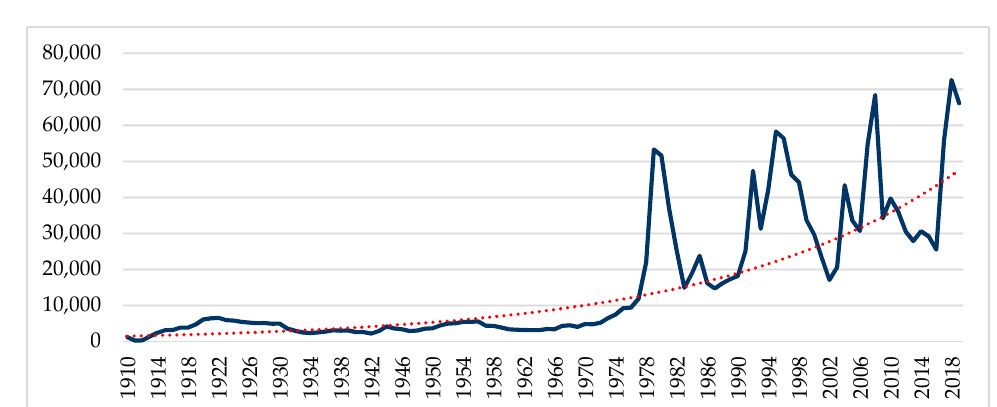
Figure A5. Co price dynamics in USD/t (build on the data from [25]), the red line is a trend.